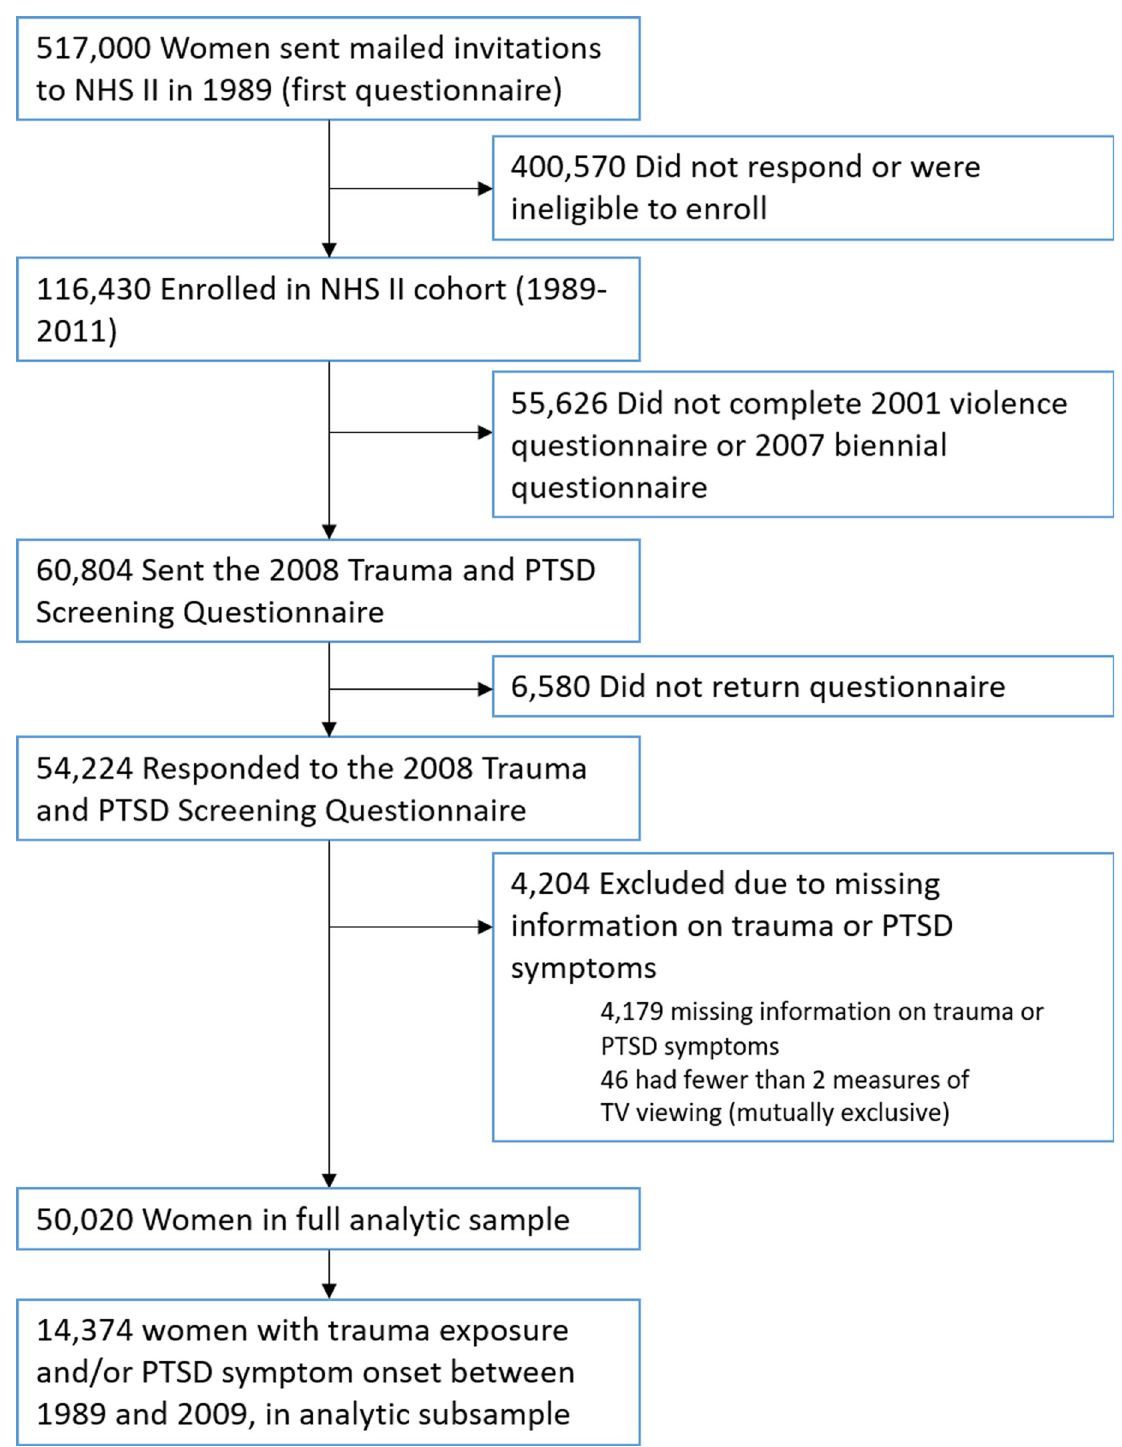
Fig 1. Flowchart of exclusions for deriving the analytic samples.